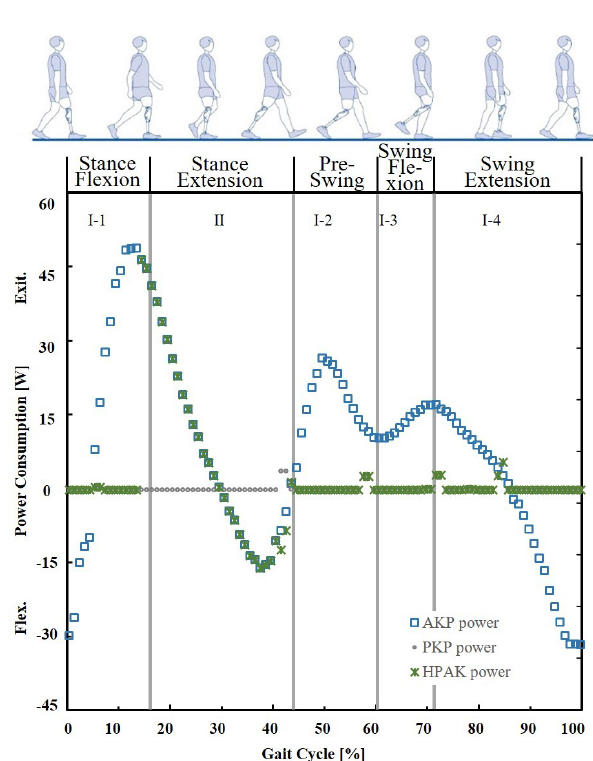
Figure 14. The power consumed by the HPAK (green points), the AKP (blue squares) and the PKP (gray circles) during a gait